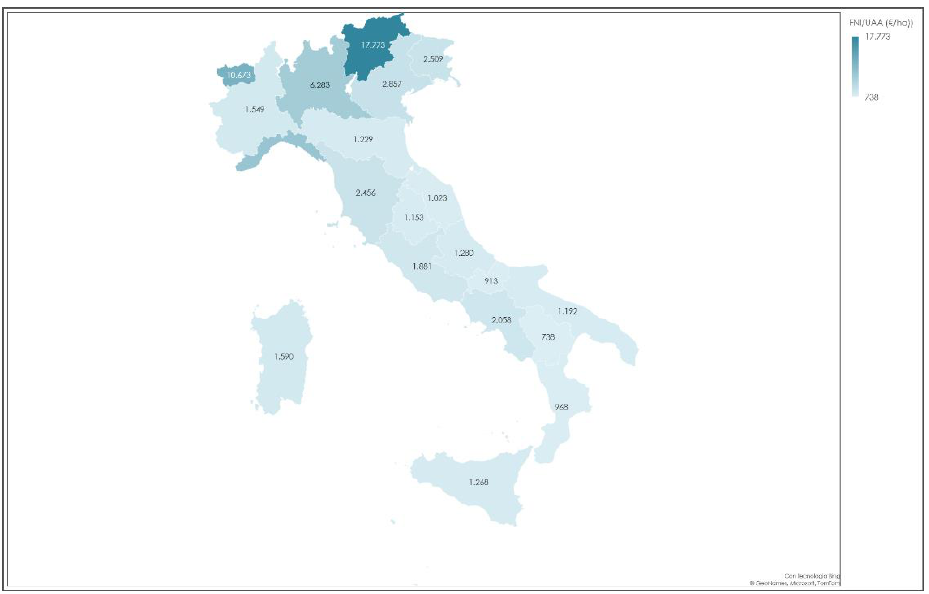
Figure 9. Net Income per hectare in the Italian regions.